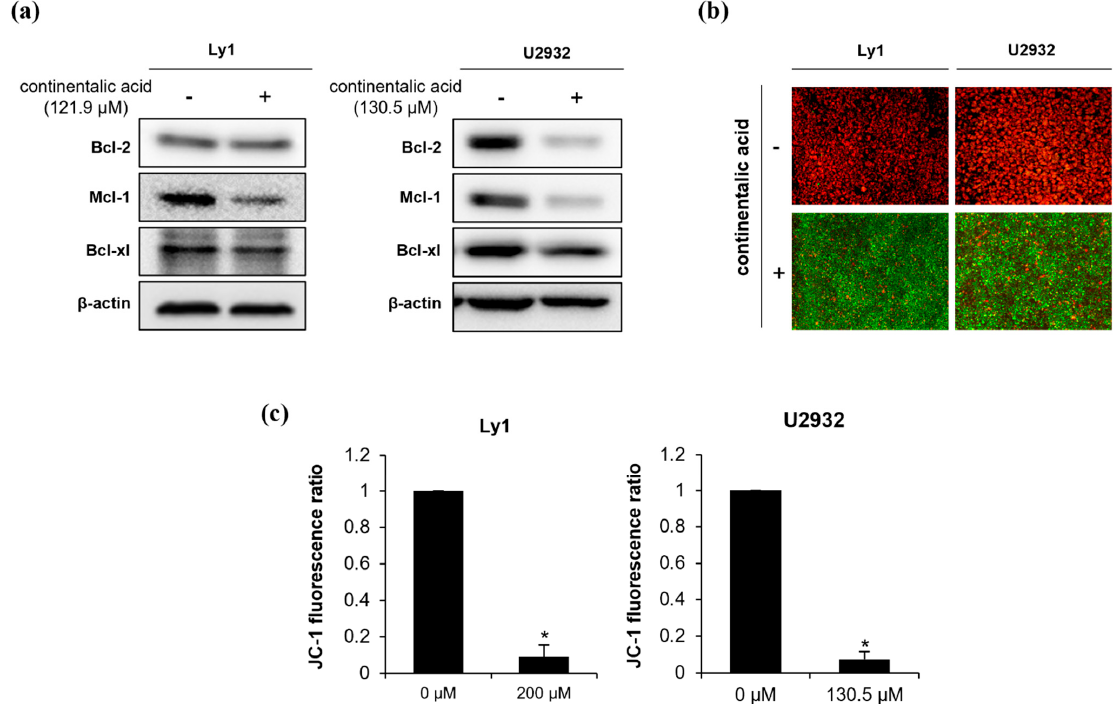
Figure 6. Continentalic acid reduces expression of anti-apoptotic Bcl-2 family members and dissociates mitochondrial membrane potential (MMP). ( a ) Continentalic acid was added in Ly1 and U2932 cells, and the expression of anti-apoptotic Bcl-2 family members Bcl-2, Mcl-1, and Bcl-xl was detected by Western blot 24 h later. β -actin served as a control for equal loading. A representative of three independent experiments is shown. ( b ) Ly1 and U2932 were treated with continentalic acid for 24 h and stained with JC-1, followed by monitoring of MMP by fluorescence microscopy. Red (J-aggregates) and green (J-monomers) colors represent intact and disrupted MMP, respectively. ( c ) MMP was calculated using flow cytometry to monitor the JC-1 fluorescence ratio of J-aggregates (red) and J-monomers (green). Statistical significance was calculated using the two-tailed Mann–Whitney test (* p < 0.05).